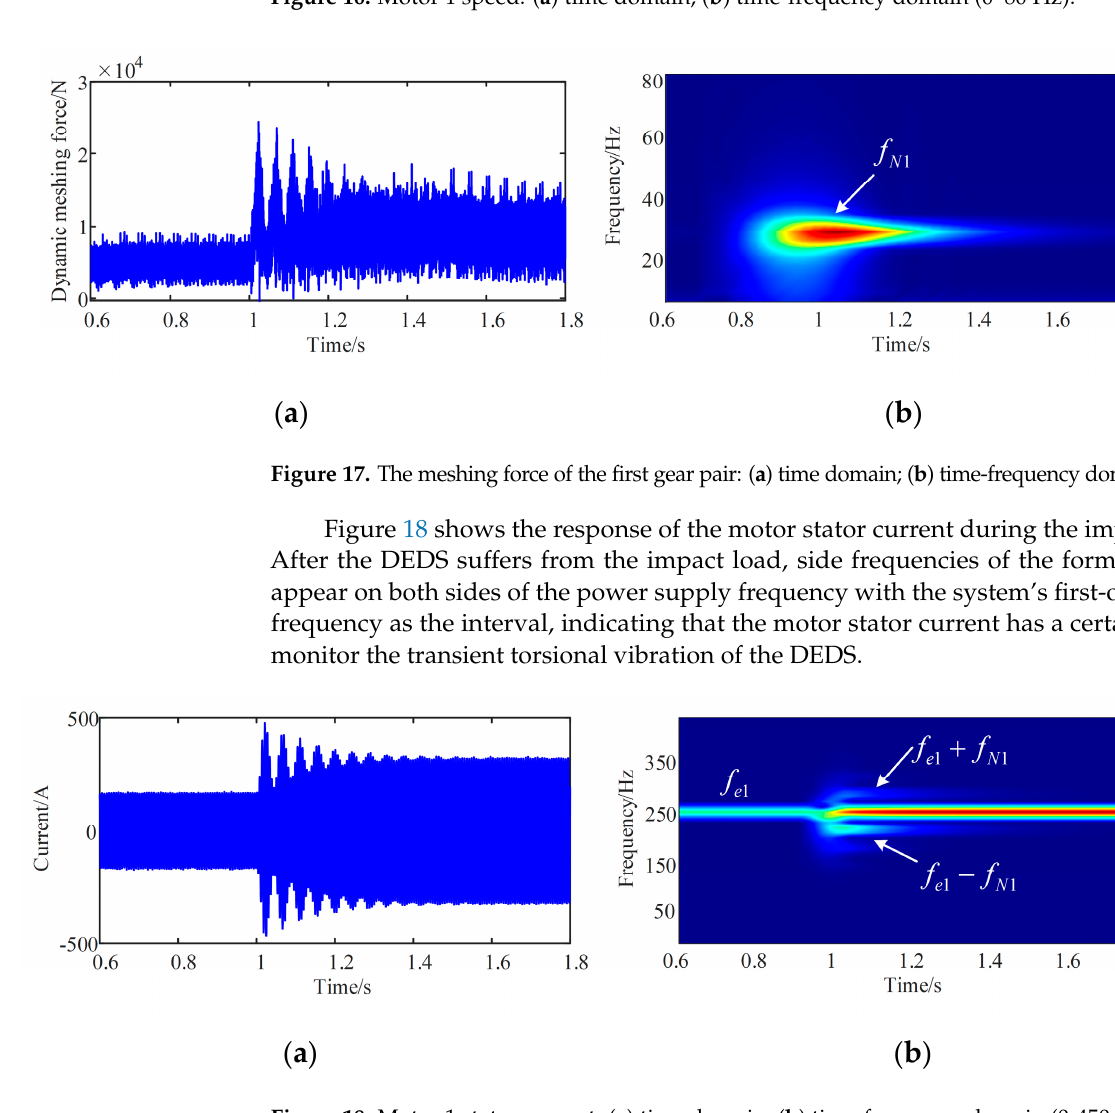
stiffness damping values on the dynamic characteristics of the gear system caused by the